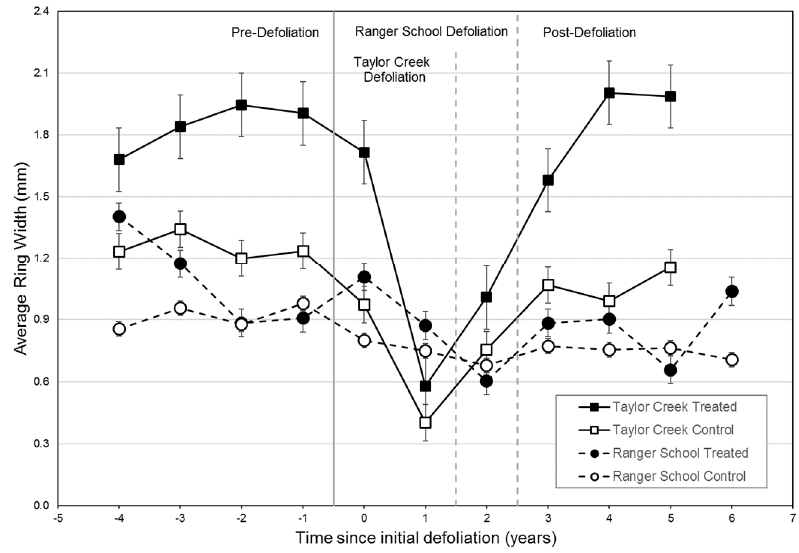
Figure 5. Taylor Creek and Ranger School mean ring width (mm) with standard error bars in relation to the initial defoliation year (zero) by site and treatment group.